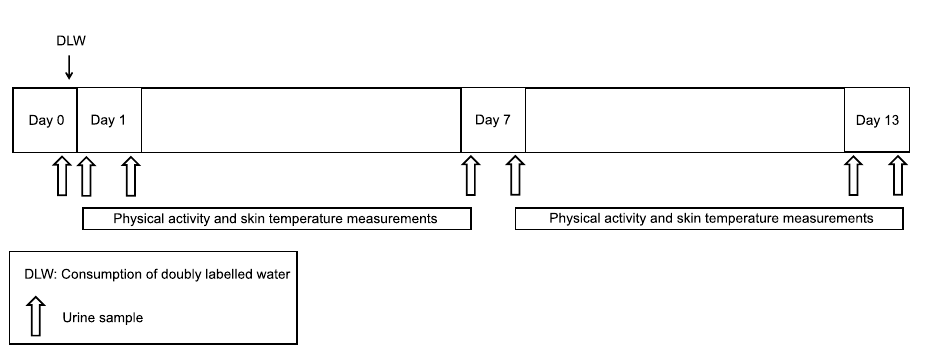
Figure 5. A map showing the location of Tuva, within Russia, where Mongolia borders Tuva’s south.